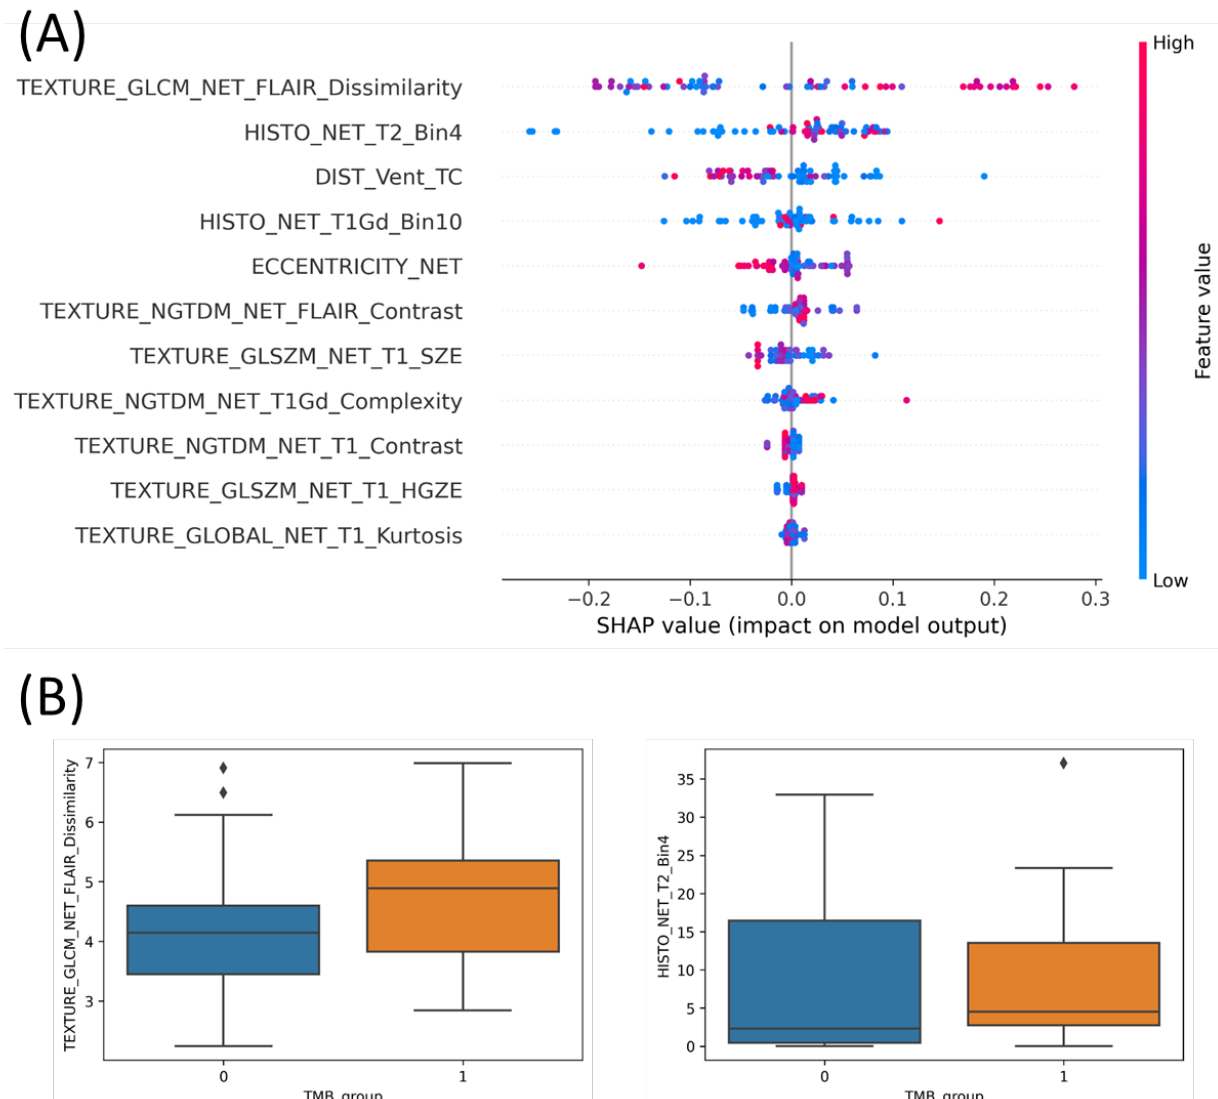
Figure 1. LightGBM model interpretation. ( A ) SHAP analysis on 11 optimal features, ( B ) correlation of two first-rank features with the TMB group. All of these model interpretation experiments were coded in Python programming language environment.